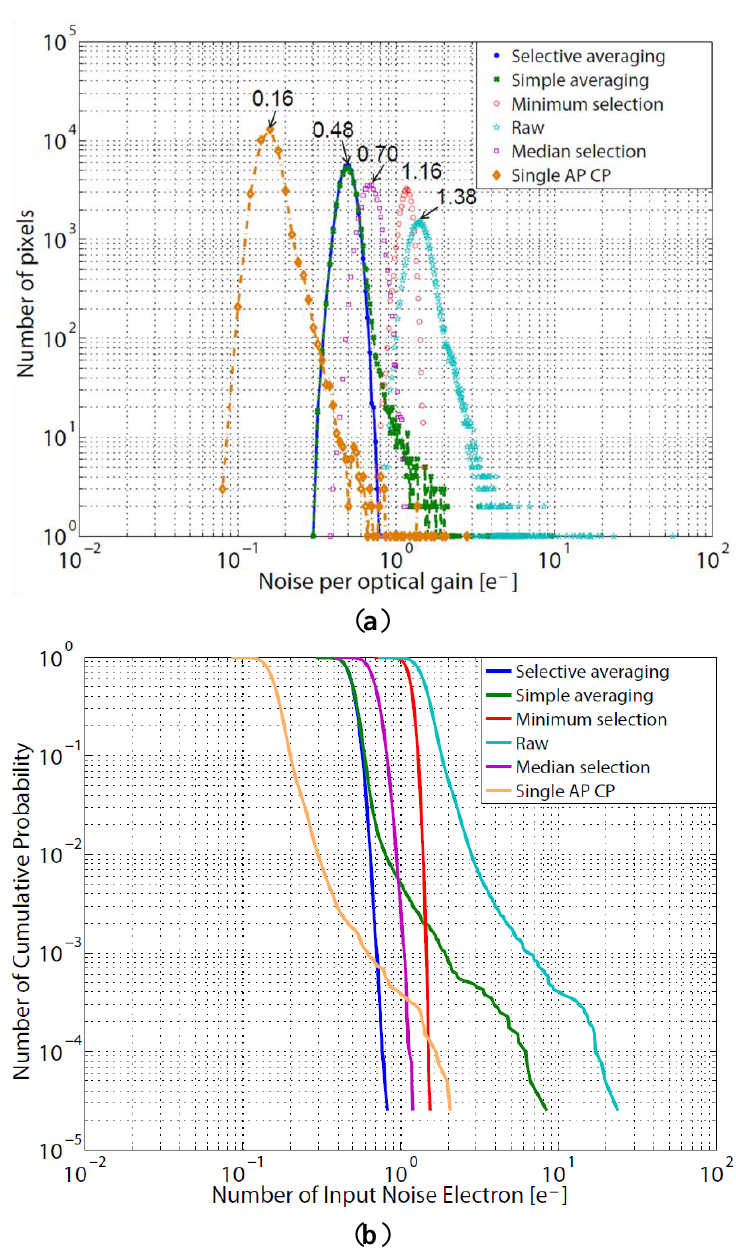
Figure 6. Noise distribution for different methods. ( a ) Histogram ( b ) Cumulative probability (AP: aperture, CP: counterpart).